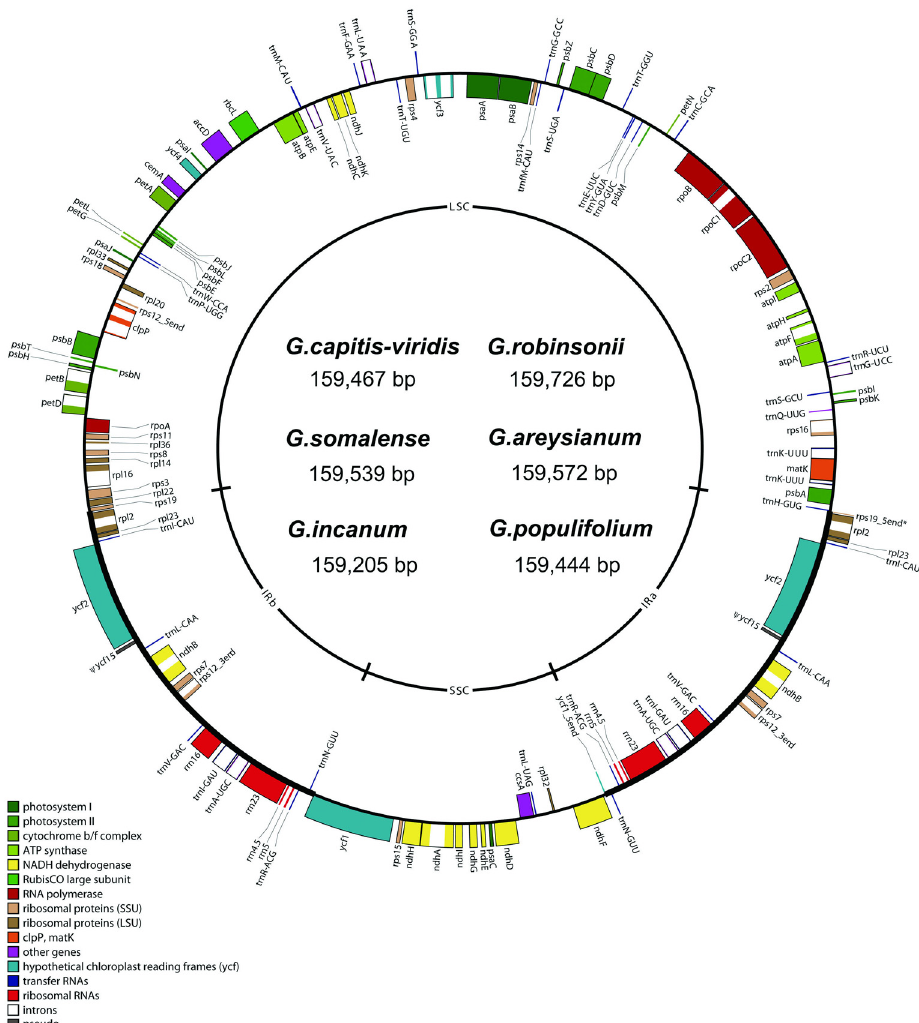
Fig 1. A consensus map of six newly sequenced Gossypium chloroplast genomes. Genes on the outside of the outer circle are transcribed in the clockwise direction and genes on the inside of the outer circle are transcribed in the counterclockwise direction. The inner circle delineates the inverted repeat regions (IRa and IRb), the small single-copy region (SSC), and the large single-copy region (LSC). Functional categories of genes are